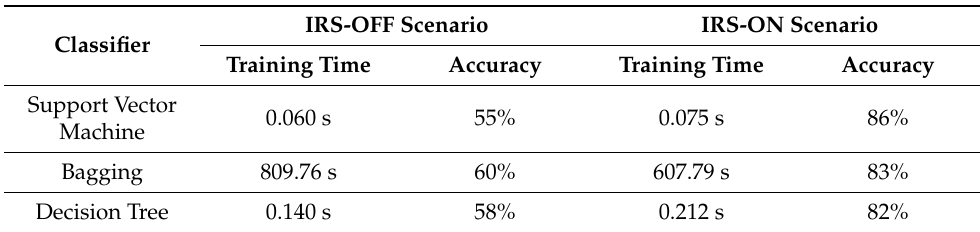
Figure 7. Classification results based on confusion matrix of multi-floor scenario. ( a ) SVM when IRS-OFF vs. ( b ) SVM when IRS-ON. ( c ) BC when IRS-OFF vs. ( d ) BC when IRS-ON. ( e ) DT when IRS-OFF vs. ( f ) DT when IRS-ON. Table 3. Machine leaning classifiers average training time in seconds and overall accuracy score on IRS-OFF and IRS-ON